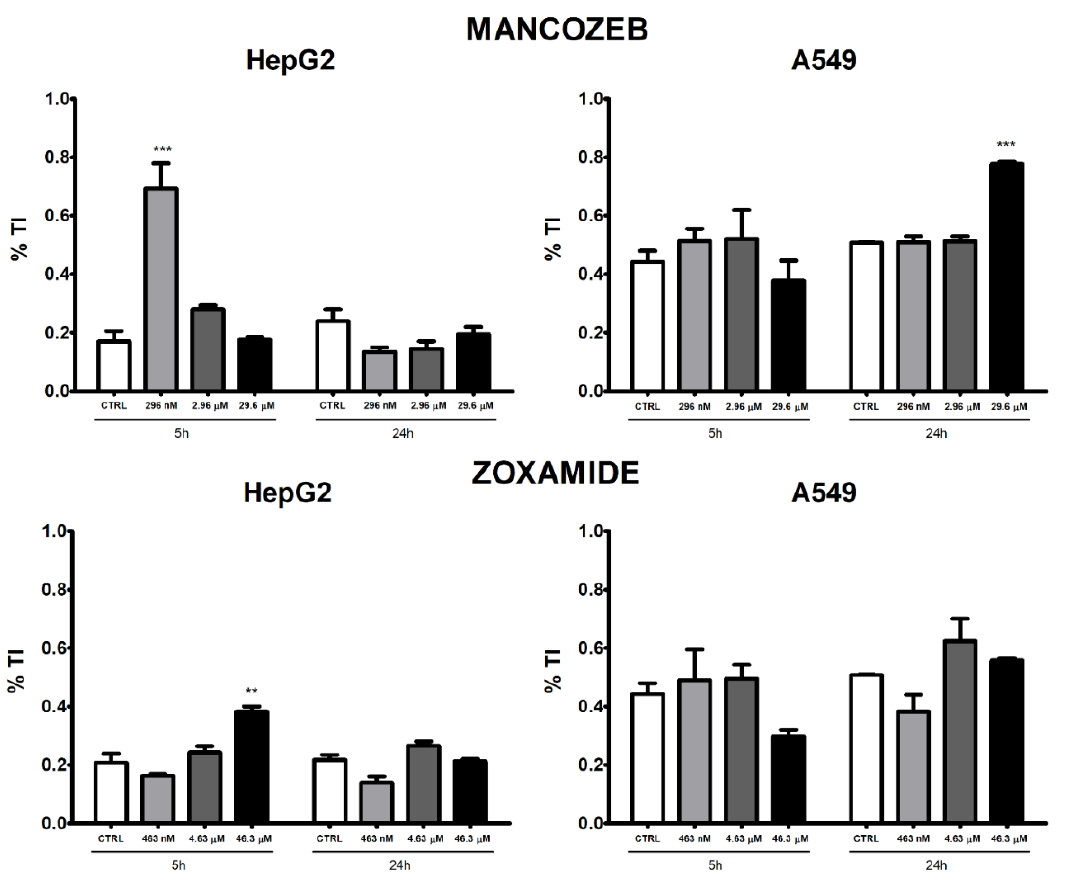
Figure 5. DNA damage measured as percentage of tail intensity (% TI) by comet assay in HepG2 and A549 cells treated with MZ and ZOX or medium alone as control for 24 h. Values are means ± SEM of three independent experiments. Statistical significance is indicated by asterisks: ** p < 0.01; *** p < 0.001.